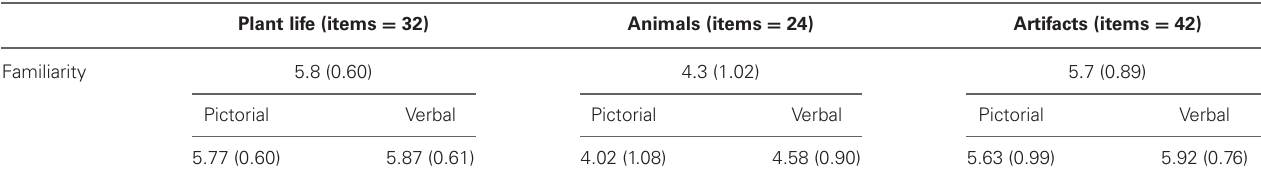
Table 1 | Mean familiarity values and Standard Deviations (in brackets) for the domains of plant life, animals and artifacts: general scores and separate scores for presentation